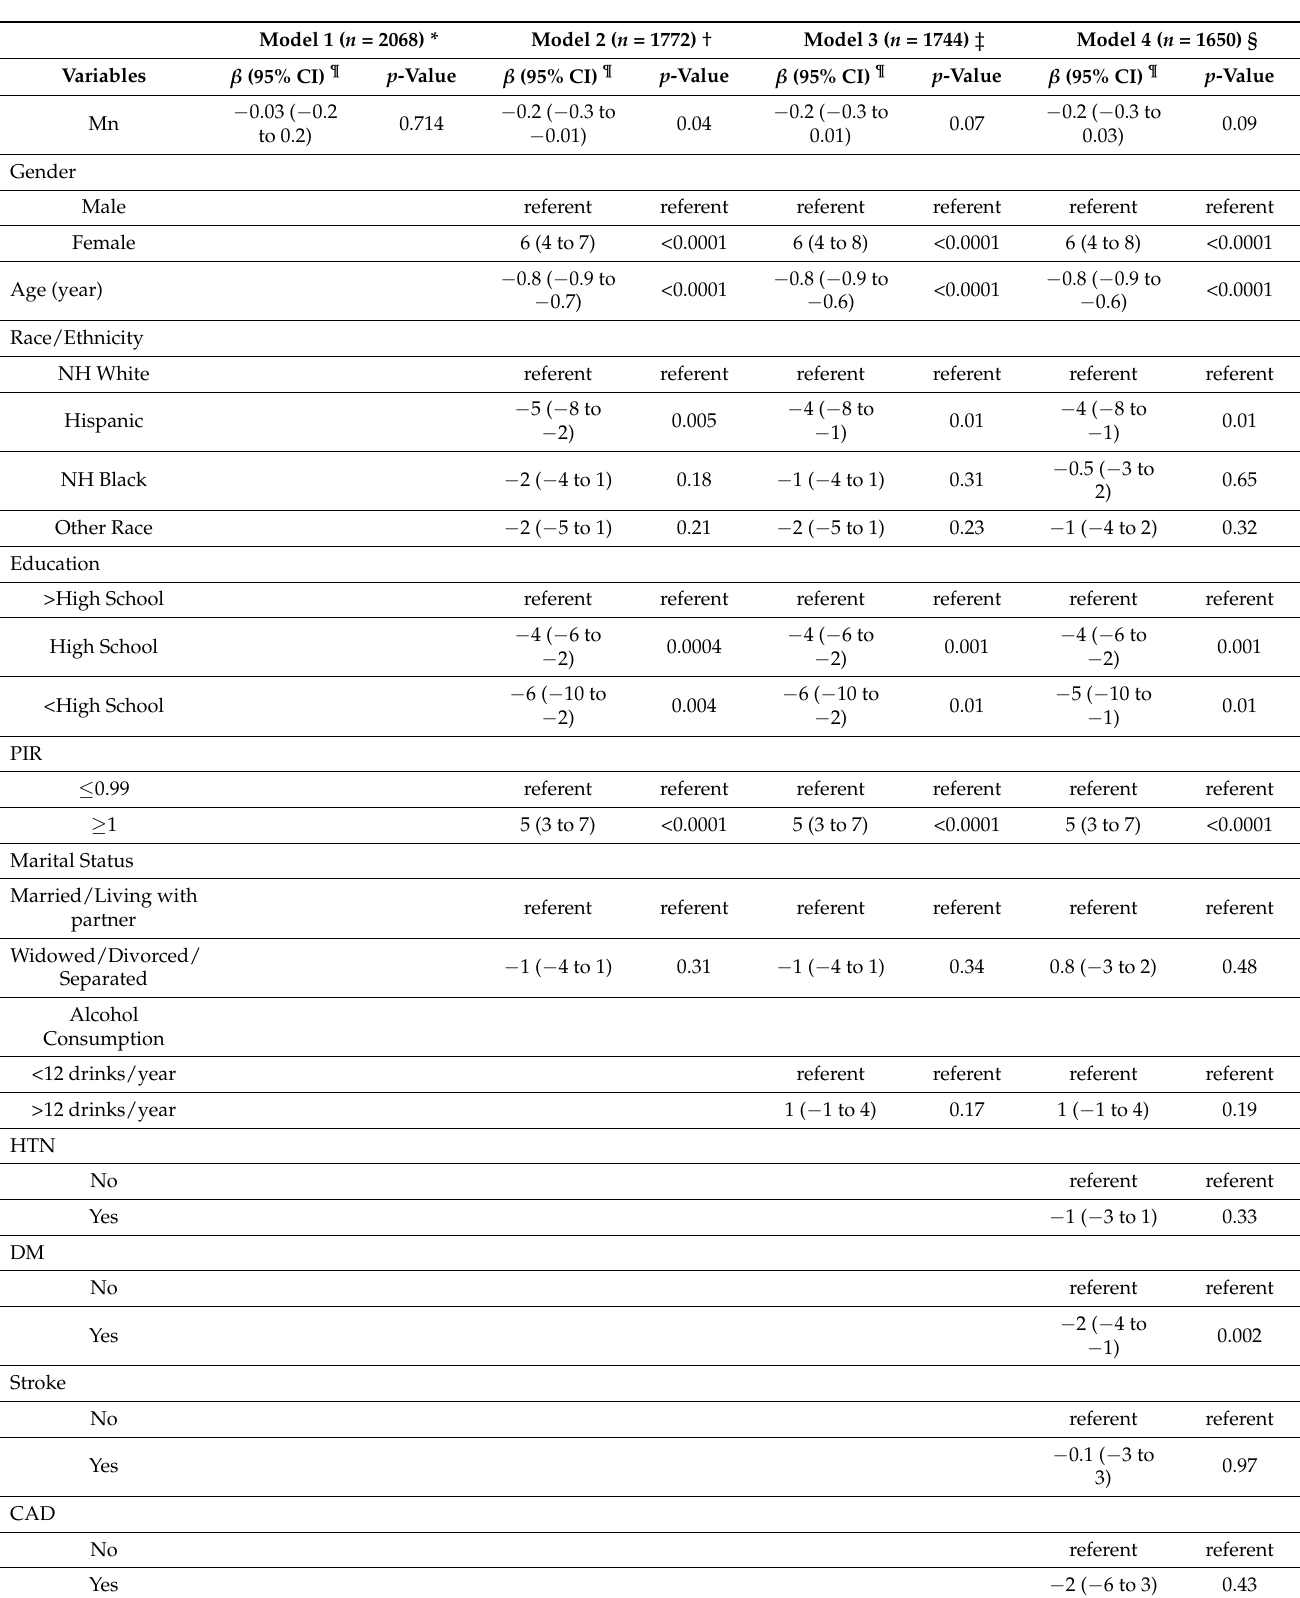
Table 2. Mn-Blood levels (continuous) in relation to CERAD